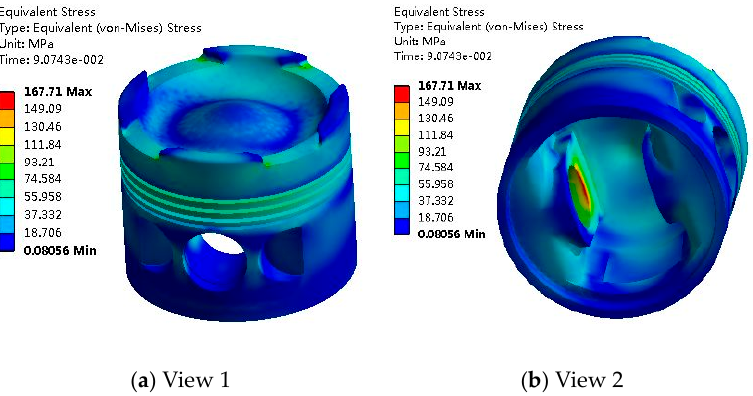
Figure 4. Distribution of piston thermal–mechanical coupling stress field. ( a ) View 1 ( b ) View 2.